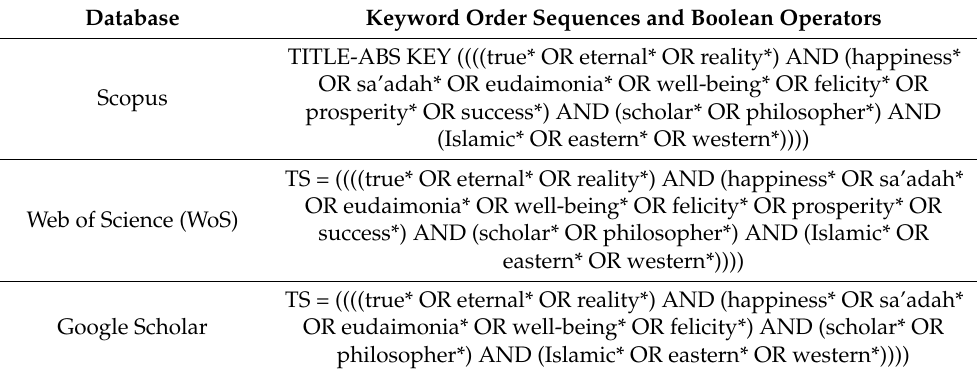
Table 1. Database resources and search series (search